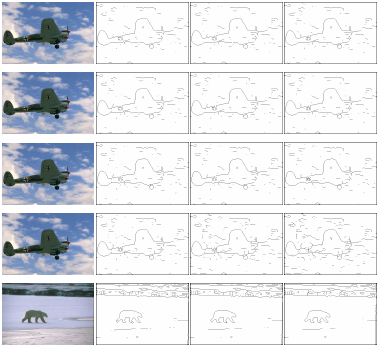
Figure A9. First-order derivative compass gradient operators and Frei–Chen operator results. Columns: Original, 3 × 3, Dilated 5 × 5 and Dilated 7 × 7. Rows:Robinson Cross, Robinson Modified Cross, Kirsch, Prewitt, Frei–Chen Edge and Frei–Chen